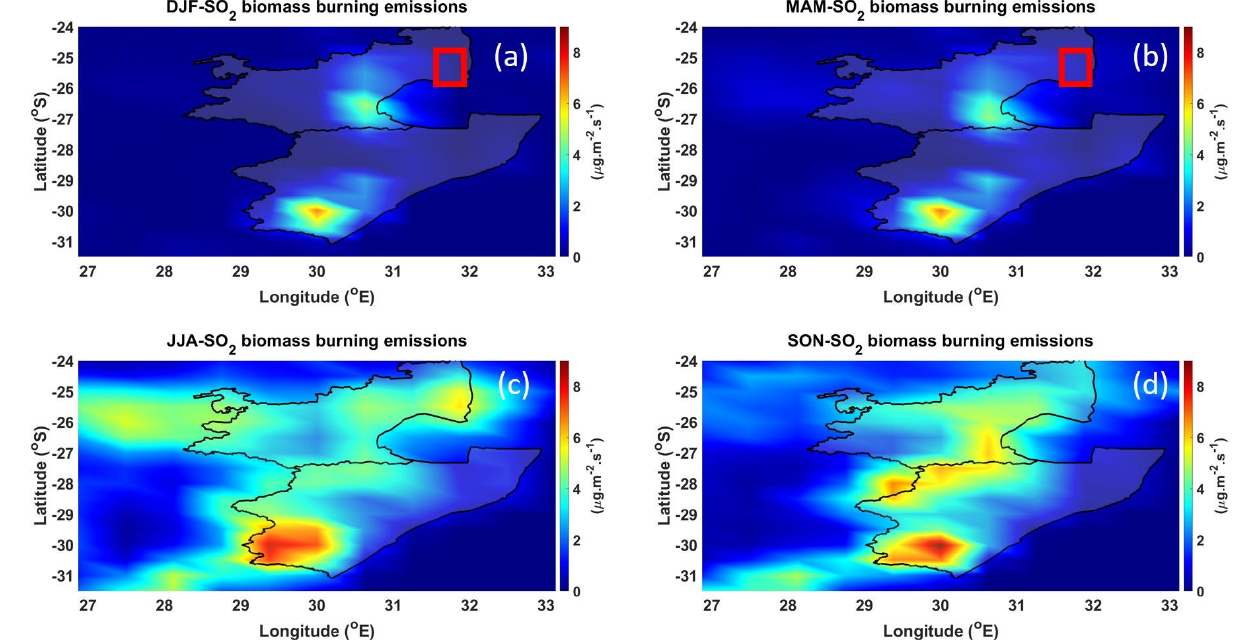
Figure 4. SO 2 biomass emissions over the MP and KZN regions during the ( a ) DJF, ( b ) MAM, ( c ) JJA, and ( d ) SON seasons. The vertical distribution of aerosols is influenced by surface winds, turbulence, and aerosol size [54,55]. The more unstable the atmosphere, the more rapidly smoke is lifted and dispersed. Under stable conditions, smoke will not rise exceedingly, except from the heat of the fire and only for short distances. Figure 5 shows the averaged seasonal vertical height distribution of smoke aerosols over the MP and KZN regions. In the JJA season (see Figure 5a), a high extinction coefficient value of ~1.3 Mm − 1 at a height of ~7 km is observed in the latitude between − 27 ◦ and − 25 ◦ . This region corresponds to the MP sugarcane plantations, and the smoke is due to the sugarcane burning, which is